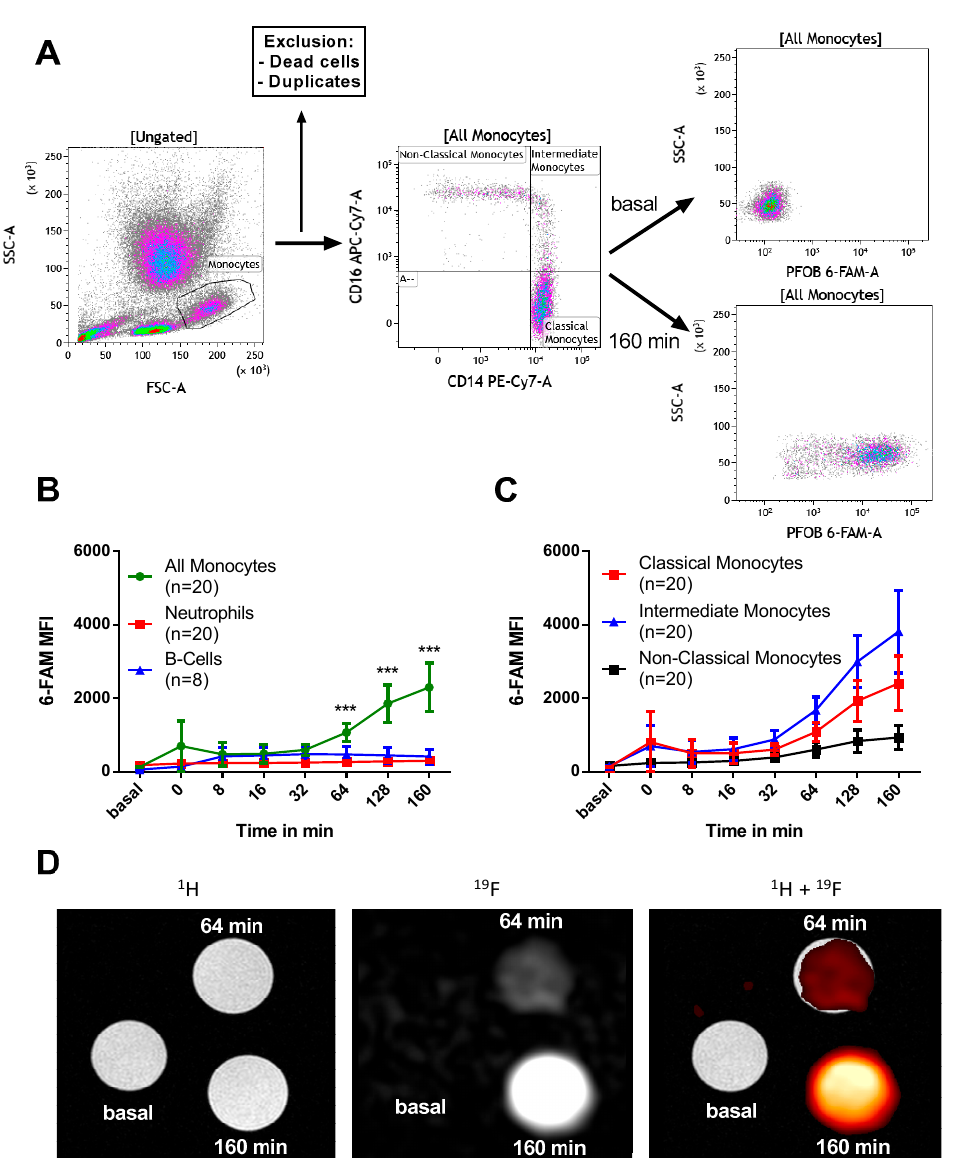
Figure 2. PFOB-NE is taken up by human leukocytes in a time- and species-dependent manner as measured by flow cytometry ( A + B + C ) and magnetic resonance imaging ( D ). ( A ) Representative gating strategy for monocytes is shown. Monocytes were identified by size and granularity (FSC and SSC). After exclusion of dead cells and cell duplicates monocyte subsets were identified by CD14 and CD16 staining. 6-FAM MFI was measured over time. ( B ) 6-FAM MFI measurements in monocytes, neutrophils and B cells and in ( C ) different monocyte subsets. ( D ) Shown are cross-sectional MR-images of tubes containing isolated monocytes at indicated time-points after PFOB-NE exposure. In 1 H-MRI, all tubes are equivalently visible. In 19 F MRI, there was a time-dependent signal increase. A merge of 1 H and 19 F MRI is shown on the right. For the sake of clarity, a hot iron color look-up table was applied to 19 F MRI